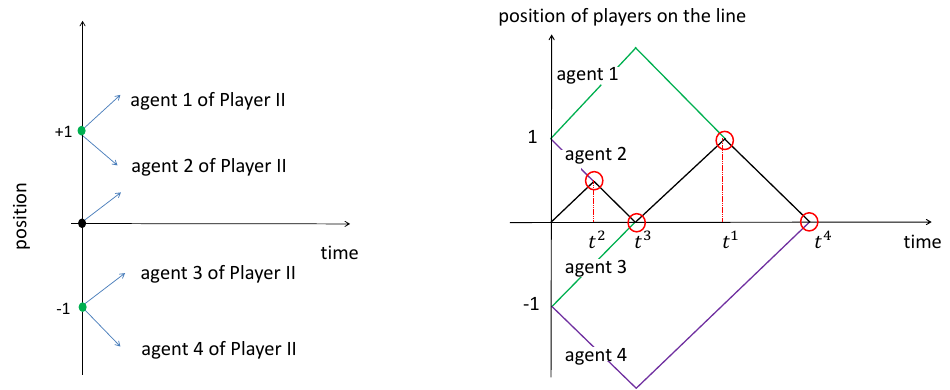
Figure 1. ( On the left ):the four agents of player II. Each one corresponds to a particular initial position and direction of the forward move. ( On the right ): the optimal solution of the game without marker. Player I goes forward for time 1 , then backward for time 1 , then forward for time 1 and 2 2 backward for time 1. Player II goes forward for time 1, then backward for time 3. The rendezvous occur successively with agents 2,3,1 and 4 at times t 2 = 1 , t 3 = 1, t 1 = 2 and t 4 = 2